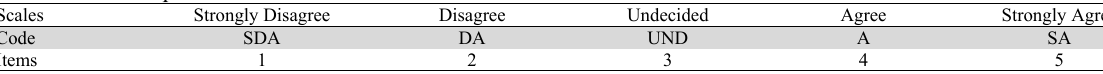
Mathematical five-point scale Scales Strongly Disagree Disagree Undecided Agree Strongly Agree Code SDA DA UND A SA Items 1 2 3 4